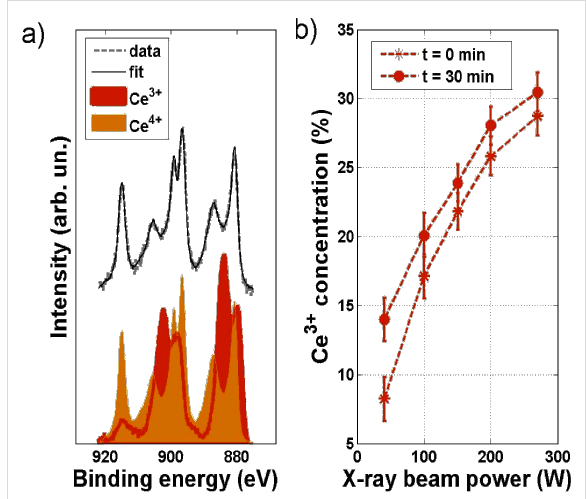
Figure 4: (a) Ce 3d XPS spectra and corresponding fit of the 9 nm sample acquired at 40 W, in the bottom region Ce 3+ and Ce 4+ XPS spectra , respectively , measured on NPs grown without oxygen in the system and then annealed in UHV at 1020 K, and on NPs oxidized directly in the aggregation chamber and then annealed in O 2 at 1020 K ; (b) Ce 3+ concentration at different X-ray power acquired on the sample at the beginning of the acquisition for each X-ray power, t = 0 min, (red circle) and after 30 min (red star) of X-ray exposure, t = 30 min.